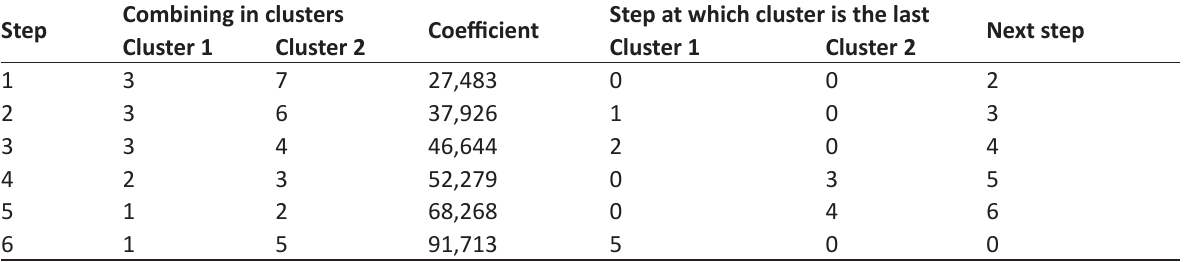
Table 4. Every athlete’s belonging to cluster